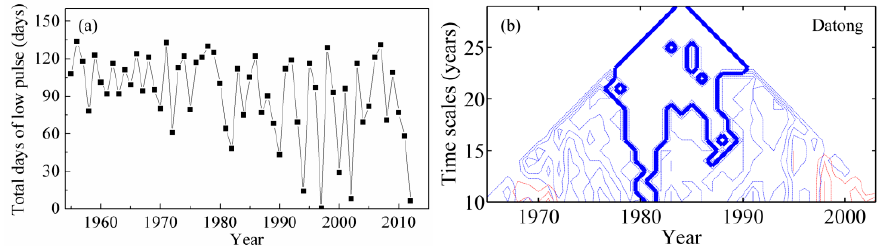
Figure 14. Changes in total days of low pulses at the Datong station: ( a ) annual values; ( b ) abrupt behaviors.